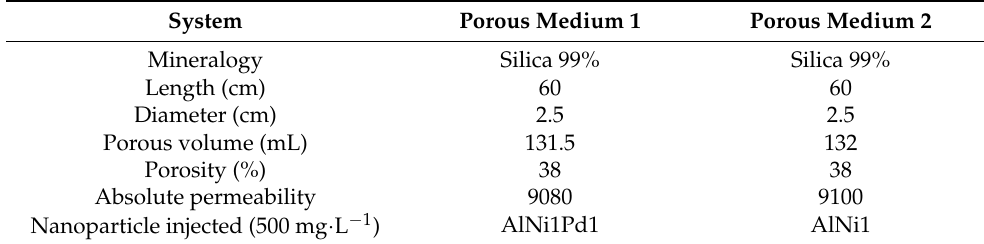
Table 1. Petrophysics properties of porous media for the steam recovery processes in absence and presence of nanoparticles at X = 0.5 and X = 1.0 quality.